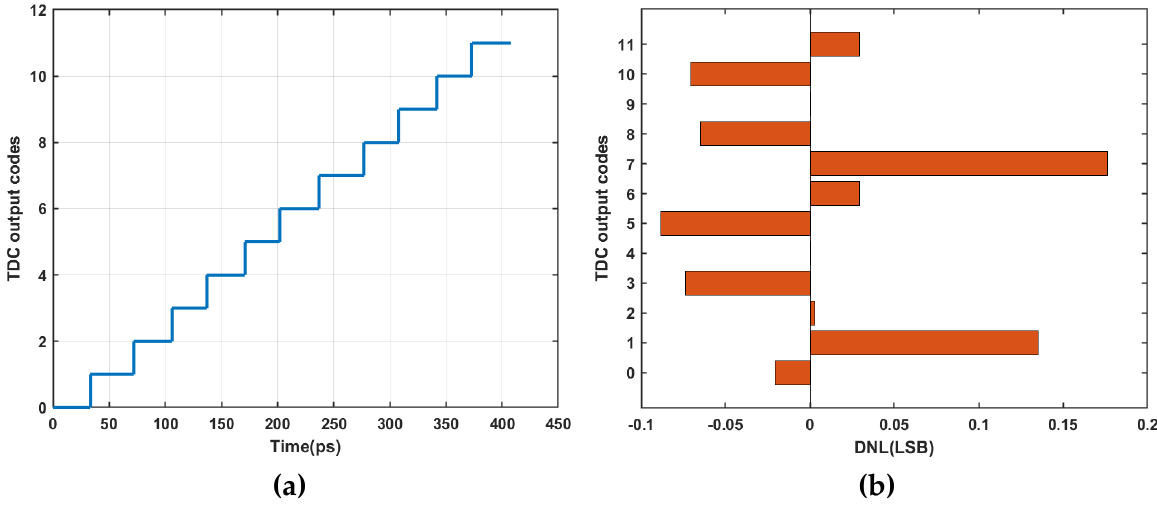
Figure 16. ( a ) TDC gain with post-layout simulation; ( b )DNL performance of